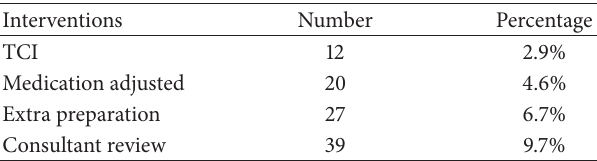
Table 4: Interventions undertaken during